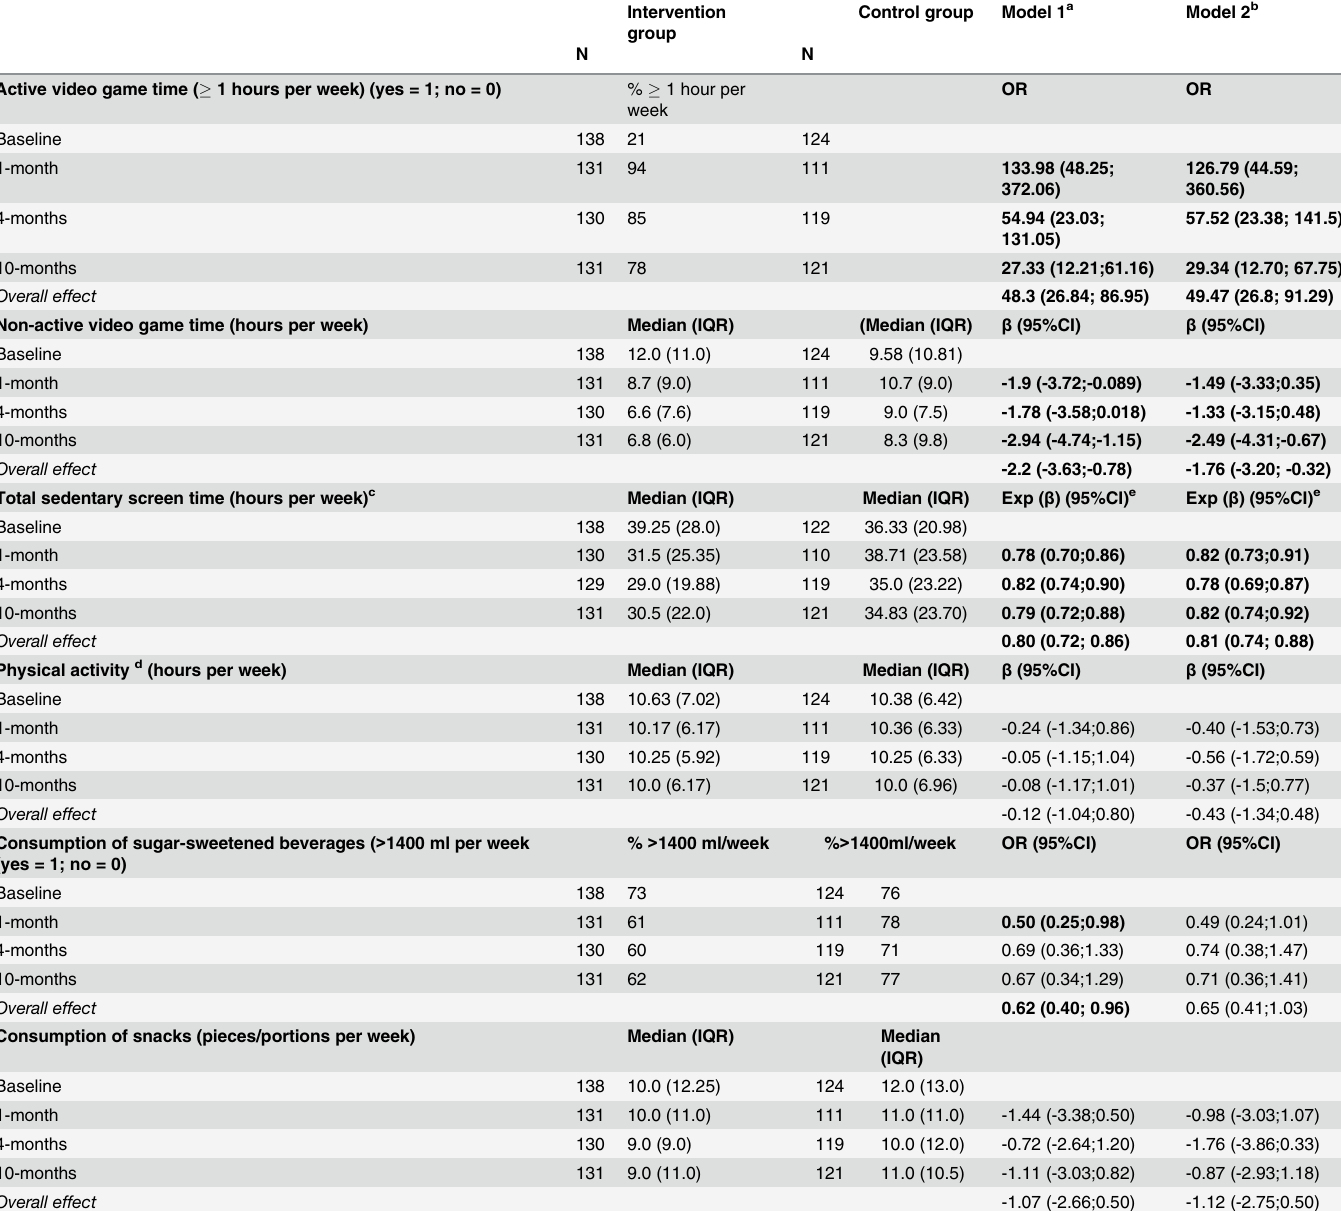
Table 3. Results of intention to treat multilevel regression analysis ( β (95% CI)) to evaluate the effects of the active video game intervention on video game behavior, sedentary screen time, physical activity and energy intake after 1, 4 and 10 months (statistical significant β with their 95% CI ’ s are printed in